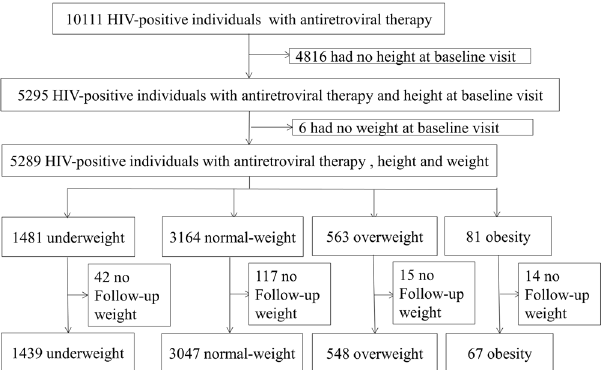
Figure 1. Chart of the inclusion and exclusion criteria in this study. A total of 10,111 HIV-positive patients received combination ART in the study settings, but 4816 had no height data and 6 had no weight data at baseline, and 190 had no weight data during follow-up; these patients were excluded, leaving a total of 5,101 individuals enrolled in this